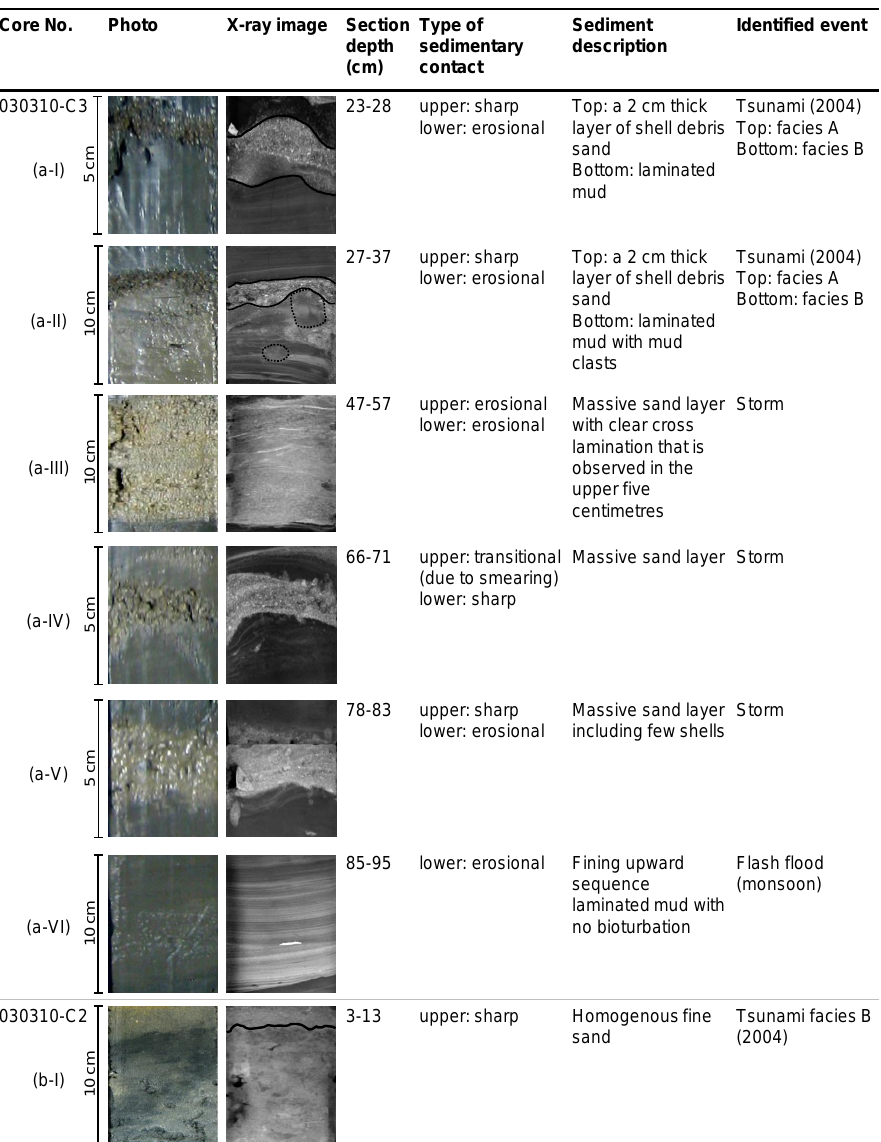
Table 3: Characteristics of the sedimentary deposit in shallow water and their event 1 Table 3. Characteristics of the sedimentary deposit in shallow water and their event interpretation. interpretation.